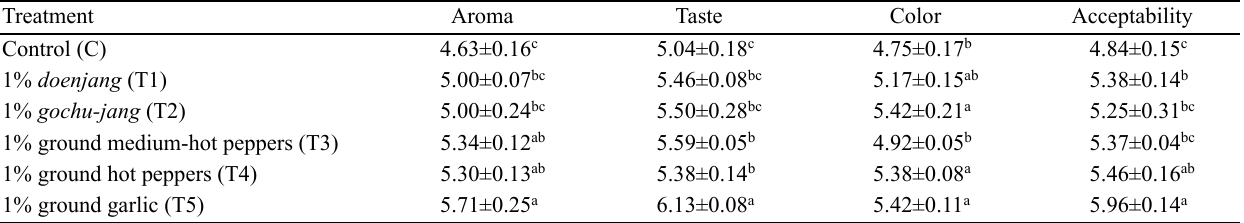
Table 6. Sensory characteristics of fermented sausages as affected by the seasonings addition 1 Treatment